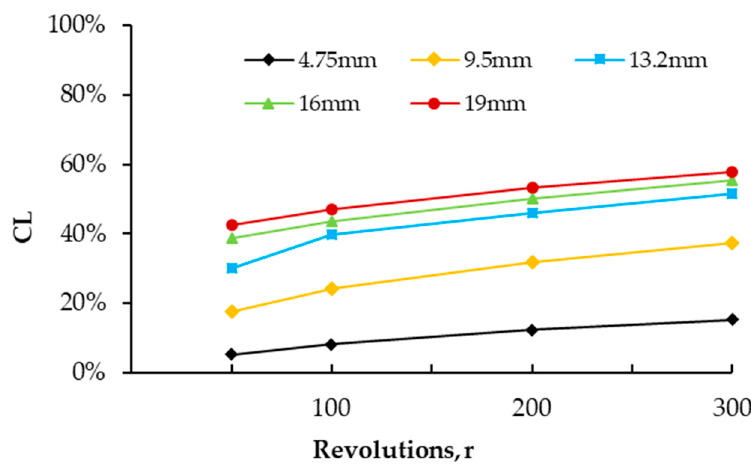
Figure 7. Effect of Revolutions on the Crushing Loss Rate of RAP 2.